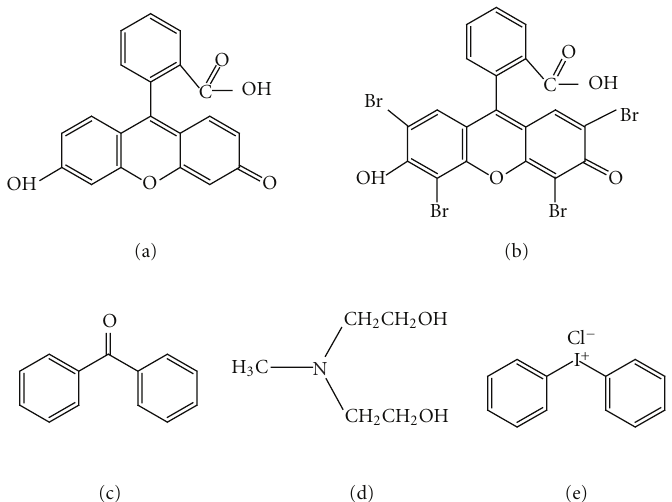
Figure 1: Chemical structures of (a) fluorescein (FL), (b) eosin Y spirit soluble (EYss), (c) benzophenone (BP), (d) N-methyldiethanolamine (MDEA), (e) diphenyl iodonium chloride